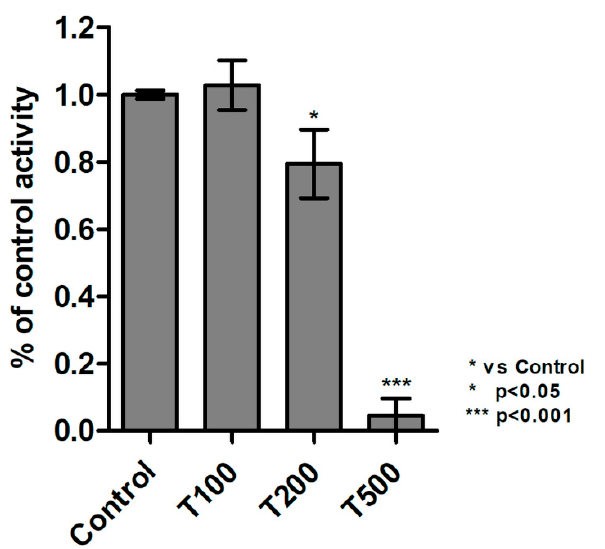
Figure 9. Results of protein tyrosine kinases (PTK) activity assay. The results were calculated as % of control values which were averaged to define the 100%. The values of PTK in samples were standardized to the viability of cells obtained in MTT assay. The RPMI 8226 cells were treated with teriflunomide (T) (100–500 µ M) or DMSO as vehicle in control cultures for 24 h. Values were presented as mean ± SD derived from three independent